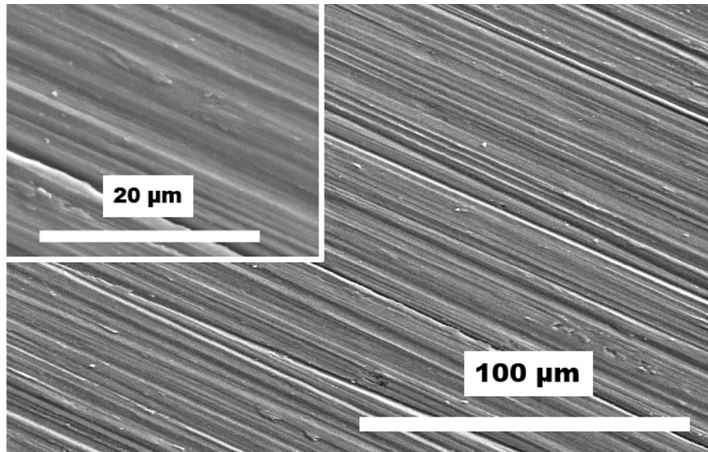
Figure 1. Surface of titanium substrate after grinding by SiC P800.